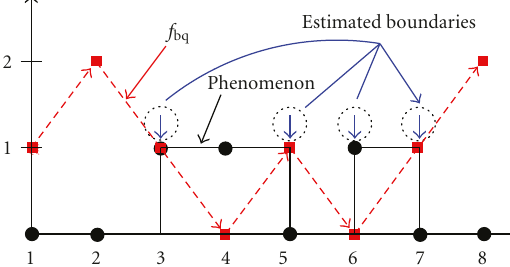
Figure 2: Illustrative example: the phenomenon under observation (solid line with circles) and the corresponding reconstruction function f bq in (14) (dashed arrows). The estimated edges are indicated by vertical